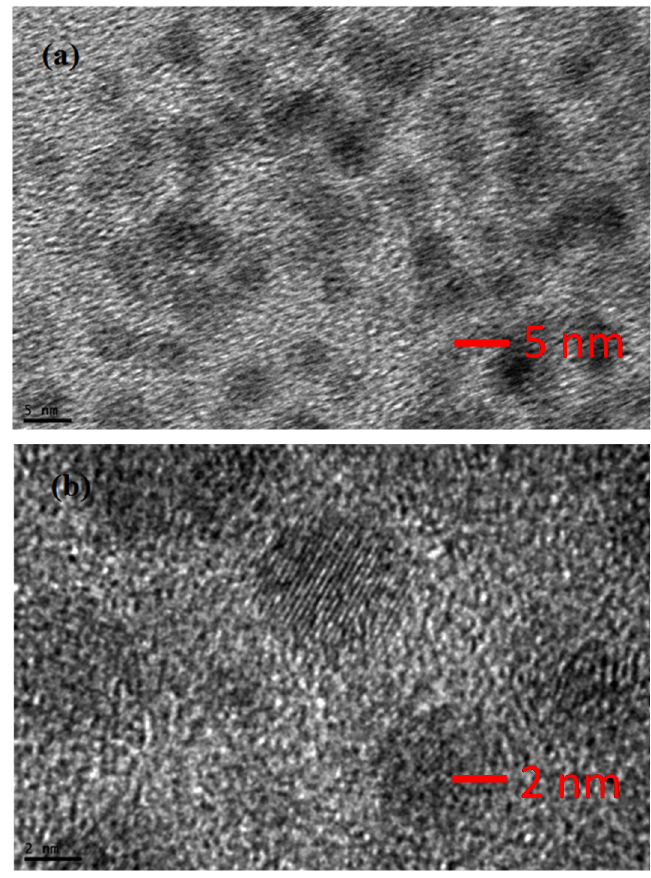
Figure 4. Field emission transmission electron microscopy images of CdS QDs in ( a ) low resolution and 5 nm ( b ) High resolution 2 nm.